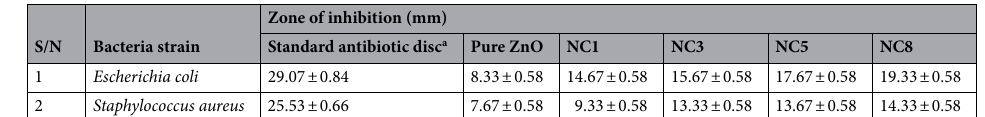
Table 1. Antibacterial activity of the synthesized nanomaterials using agar disc diffusion method at a MIC of 1.5 mg/ml. a Ciprofloxacin.